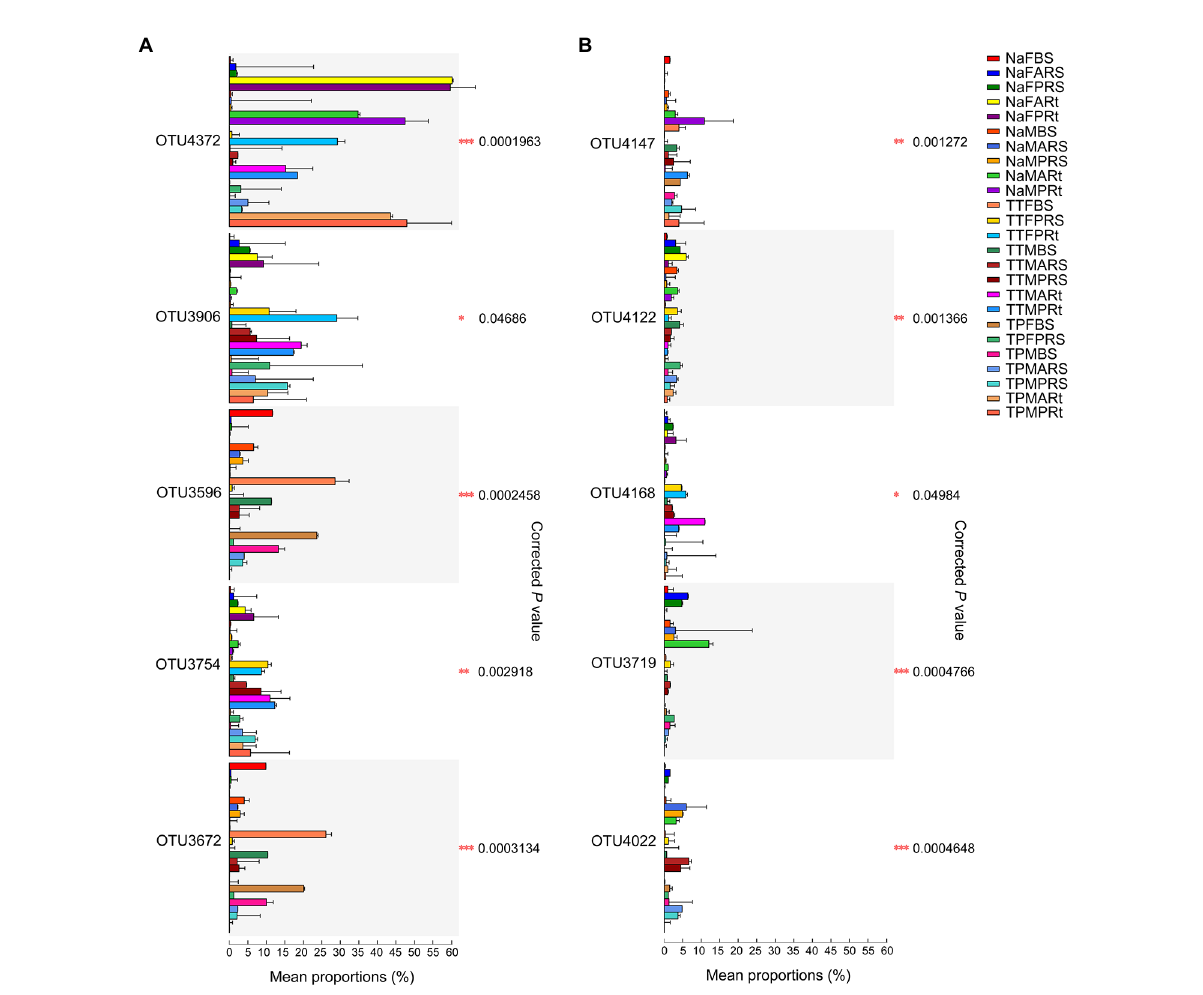
FIGURE 7 Top 10 OTUs among 25 group comparisons via Kruskal–Wallis H test followed by Tukey–Kramer post hoc test. (A) Top 5 OTUs. (B) Top 6th–10th OTUs. The mean proportion (%) is the average relative abundance of taxa in different groups, and the standard deviation (SD) bar is displayed. * , ** and *** indicate p < 0.05, p < 0.01 and p < 0.001, respectively. The treatment details are shown in Figure